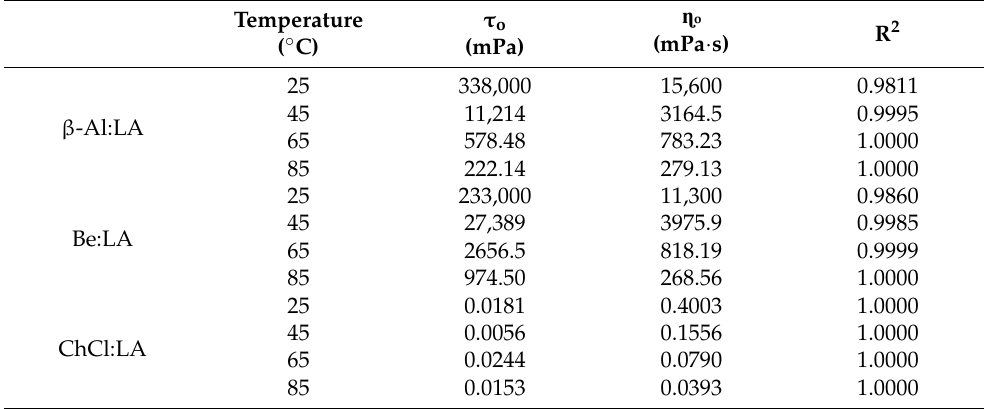
Table 3. Bingham yield stress and plastic viscosity data for the studied systems at temperatures from 25–85 ◦ C.